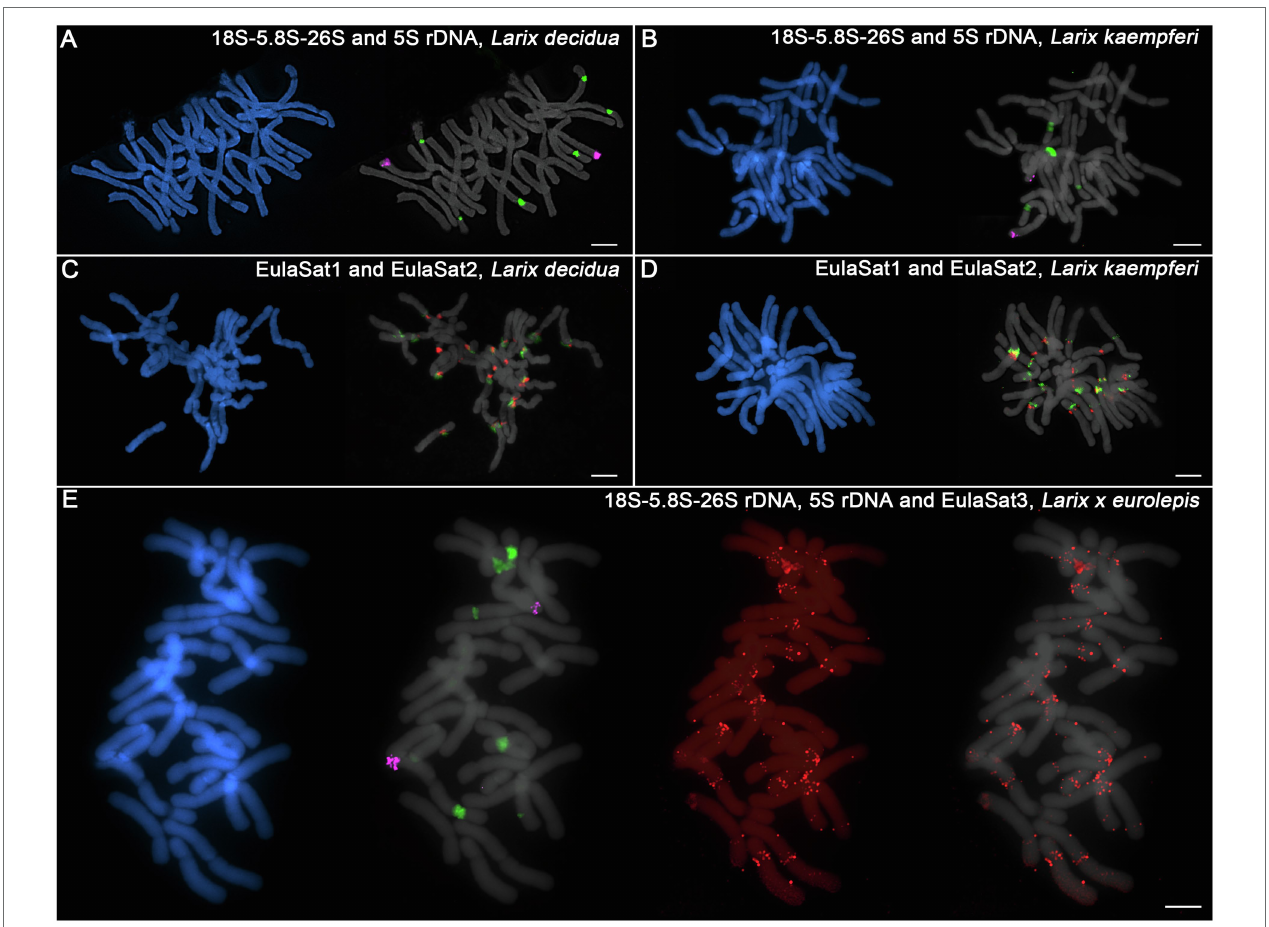
FIGURE 7 | Chromosomal location of rDNAs and the EulaSat families for comparison of L. kaempferi , L. decidua , and L. × eurolepis . The chromosomes have been counterstained with DAPI, indicated in blue and gray. Reproduced are fluorescent in situ hybridizations of the 5S (magenta) and 18S-5.8S-26S (35S) rDNAs (green) to metaphases of L. decidua (A) and L. kaempferi (B) . EulaSat1 (green) and EulaSat2 (red) were comparatively hybridized along metaphase chromosomes of L. decidua (C) and L. kaempferi (D) . The genome-specific EulaSat3 family (red) was hybridized along chromosomes of the interspecific L. × eurolepis hybrid, along with probes for the 5S (magenta) and 35S rDNAs (green; E